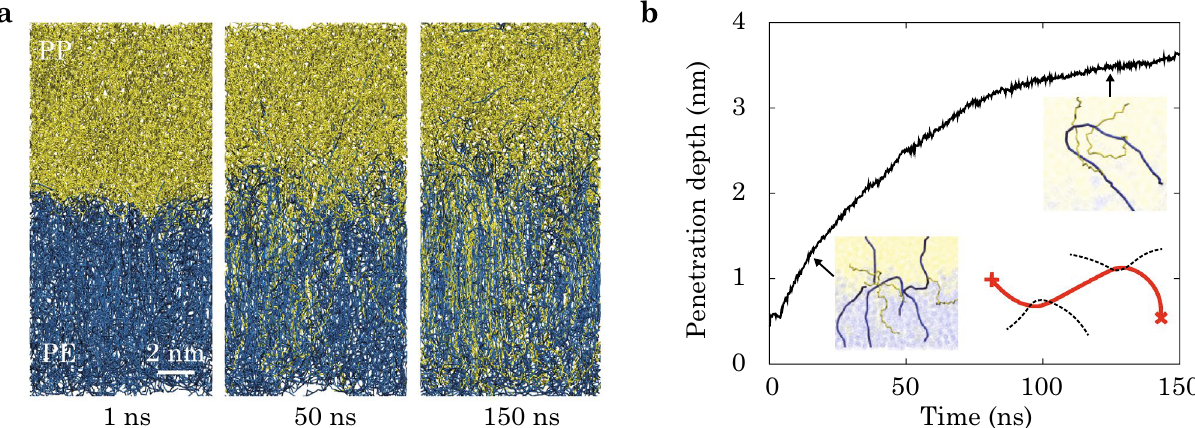
Figure 2. ( a ) Snapshots of heat-fusion processes at the PE (bottom)/PP (upper) interface and ( b ) the penetration depth plotted against fusion time, obtained from the coarse-grained molecular dynamics (CGMD) simulations. The insets of representative polymer chains illustrate kinetic steps of inter-diffusion and entangling, respectively. A cartoon showing the definition of two topological constraints (TCs, black) on a primitive path (red) is also included. The fusion conditions are 500 K and 1